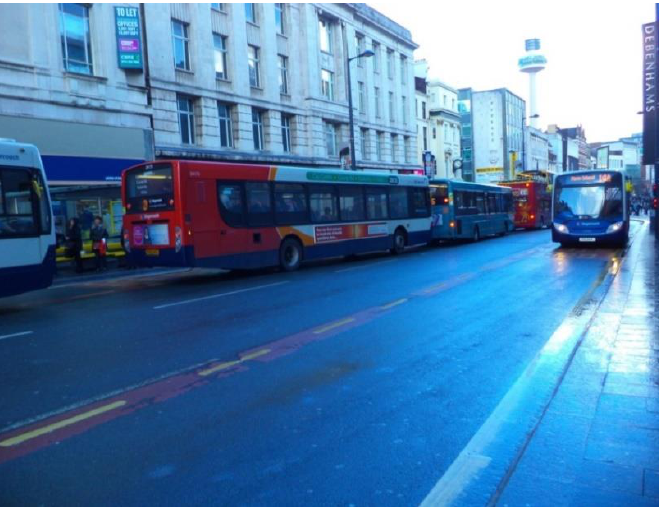
Figure 6. Example of transportation options promoting respect and social inclusion (P20) (Buses in Liverpool city centre).